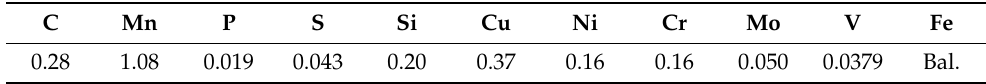
Table 1. The composition of carbon steel specimens